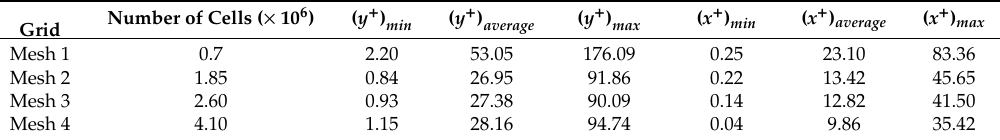
Table 2. Grid parameters used in mesh independent study.